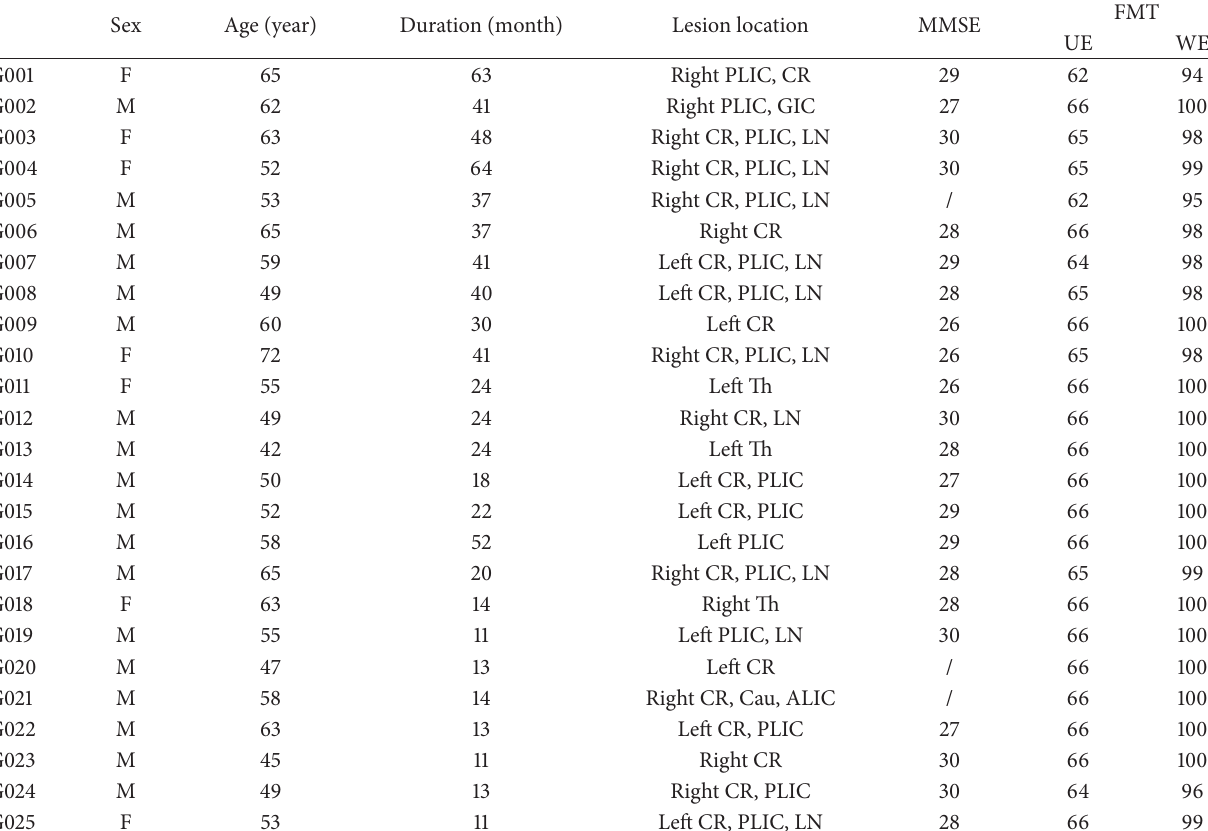
Table 1: Clinical information of stroke